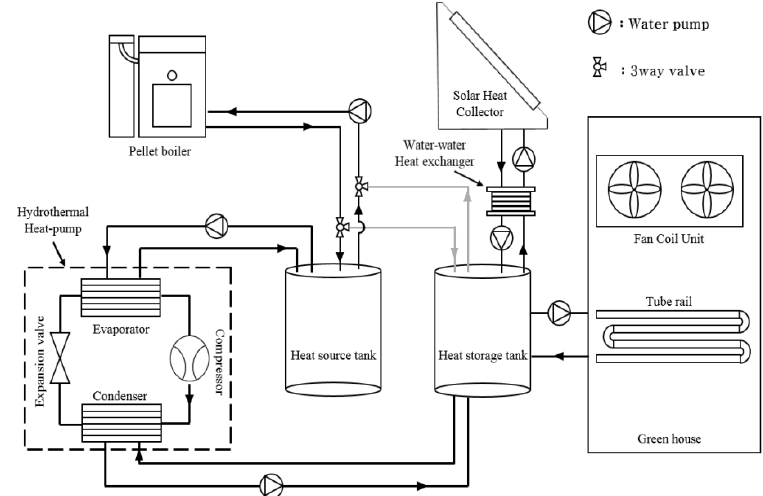
Figure 7. Schematic of hybrid system 3.